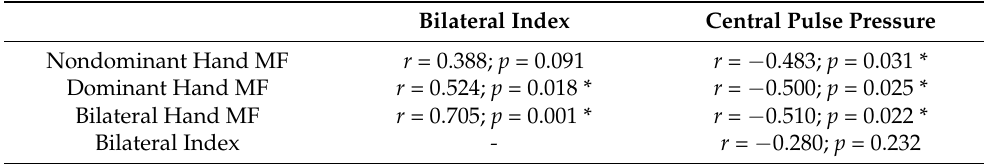
Table 2. Correlation findings in late postmenopausal